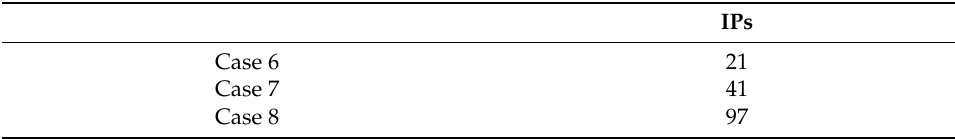
Table 7. The experimental setting in the practical experiments.